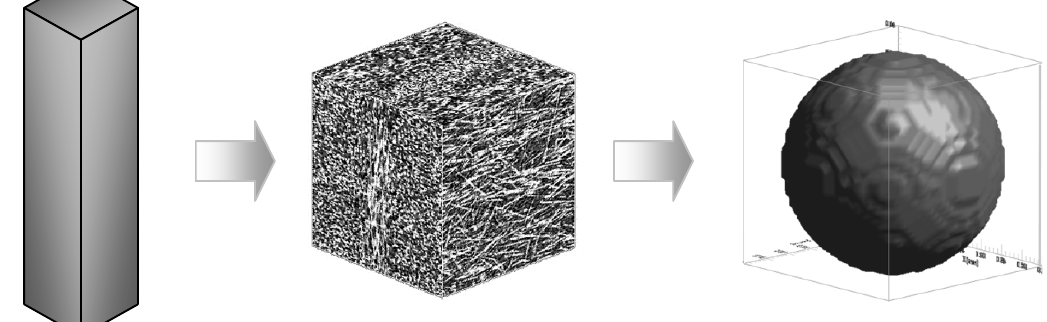
Figura 9: Volume sferico per l’analisi del MIL , estratto dal volume del campione